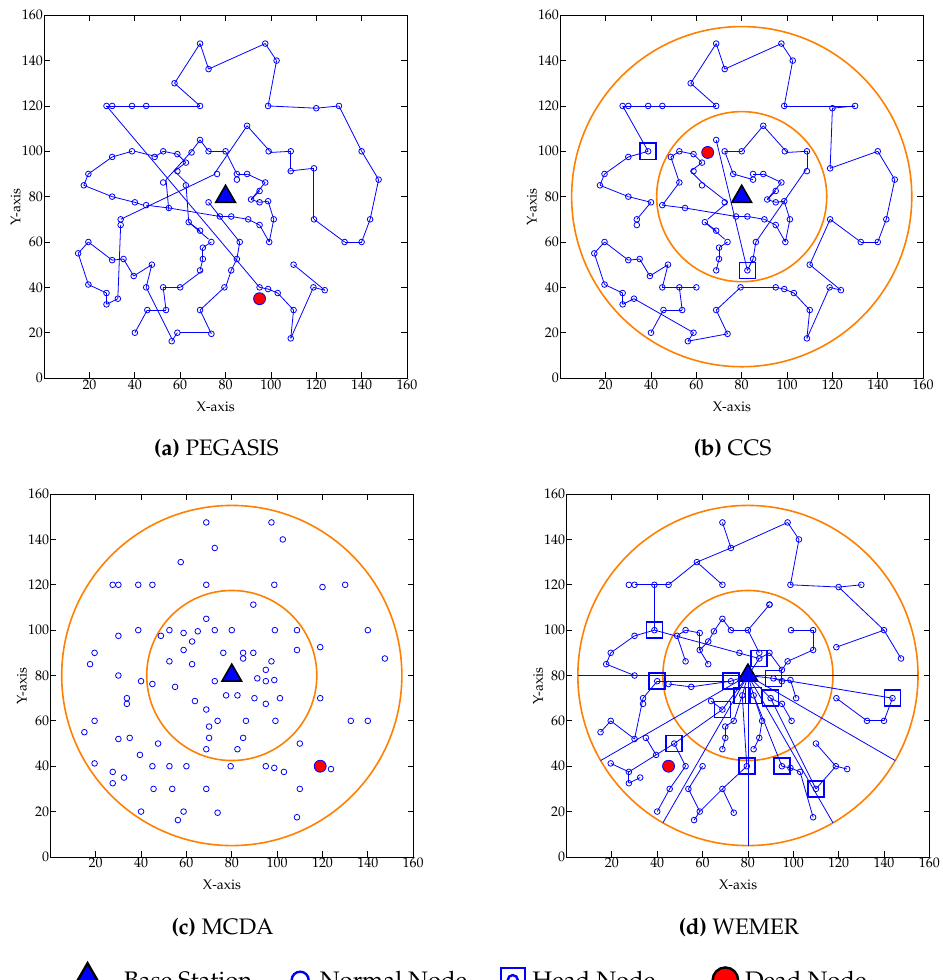
Figure 18. Network topology after First node die ( a ) at 115th round for Power Efficient GAthering in Sensor Information Systems (PEGASIS) ( b ) at 311th round for Concentric Clustering Scheme (CCS) ( c ) at 52th round for Multilayer Cluster Designing Algorithm (MCDA) ( d ) at 582th round for WEMER.